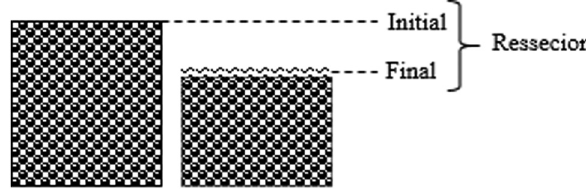
Figure 2: Recession of TPS material under the ablation test [ 5 ] .